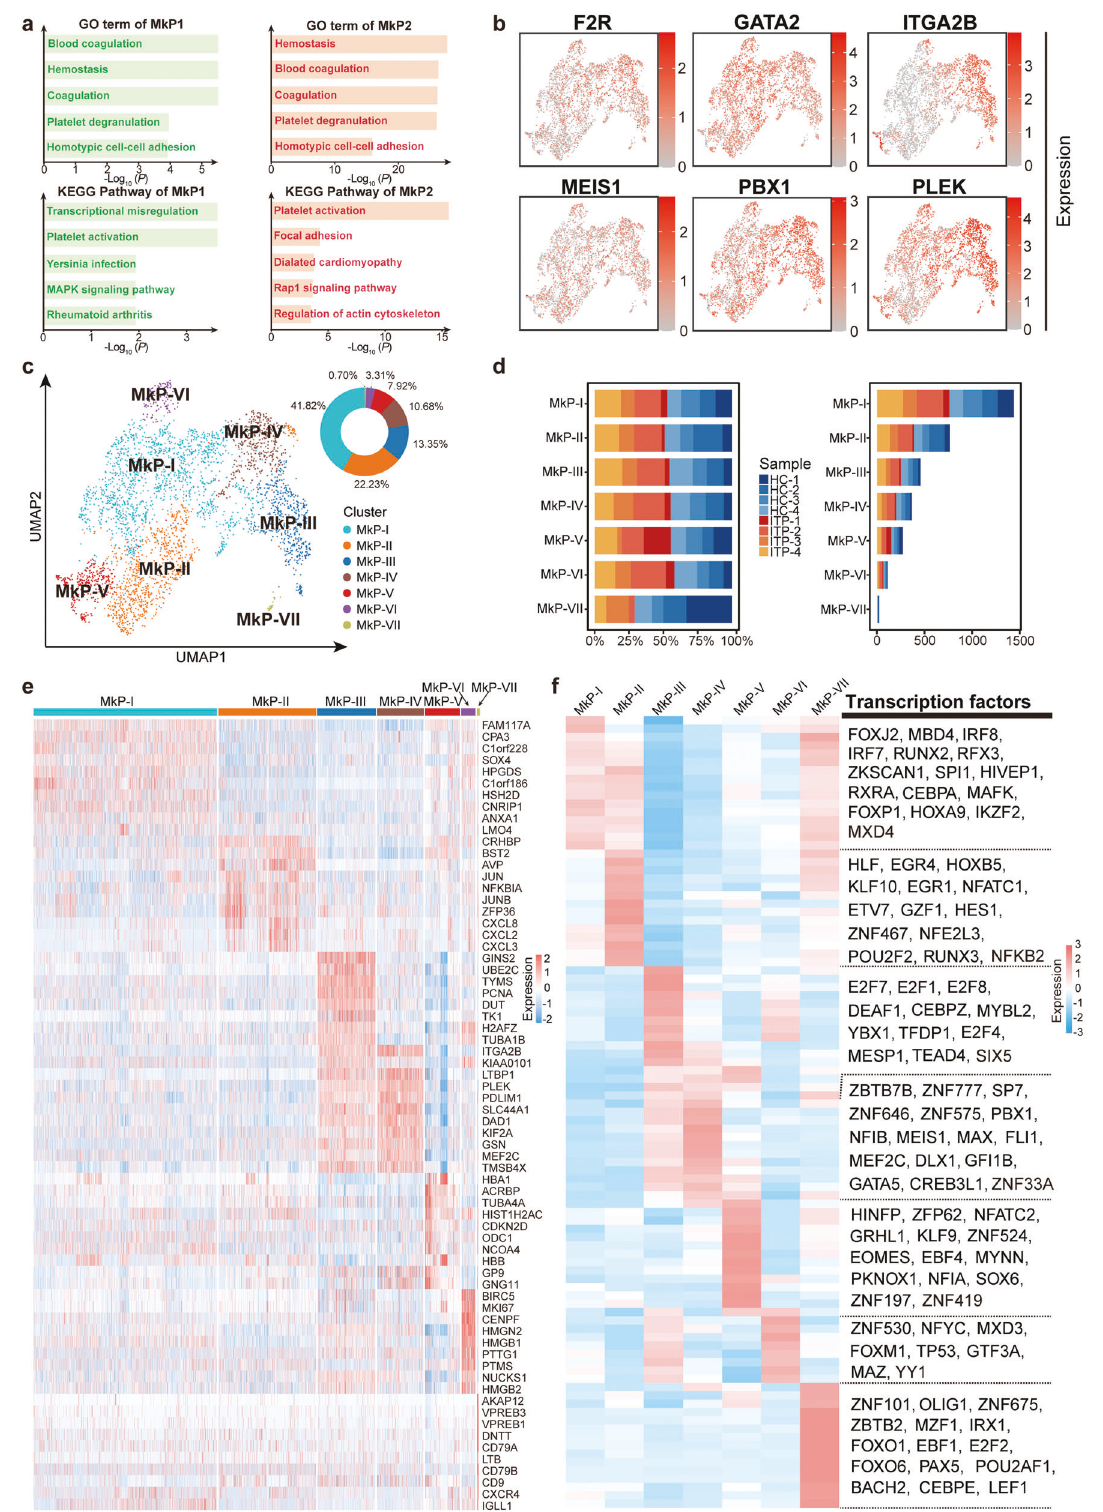
Fig. 8 Detailed analysis of MkP populations in BM. a Top 5 GO: BP terms (upper) and KEGG pathways (lower) enriched in MkP1 (left) and MkP2 (right). b UMAP plots displaying the expression of six molecular features of MkP ( F2R , GATA2 , ITGA2B , MEIS1 , PBX1 , and PLEK ). c UMAP visualization of seven subclusters, resulting from sub-dividing the BM cells in the MkP1 and MkP2 clusters described in Fig. 1c. Color according to subclusters. Pie chart showing the relative abundance of each subcluster. d Stacked barplots showing the numbers of cells from different sample sources in each subcluster (left), and proportions of cells from different sample sources in each subcluster (right). e Heat map showing the scaled expression of the top 10 marker genes in each MkP subcluster. See also Supplemental Fig. 13. f Top 15 differentially expressed TFs in each subcluster. See also Supplemental Fig. 14